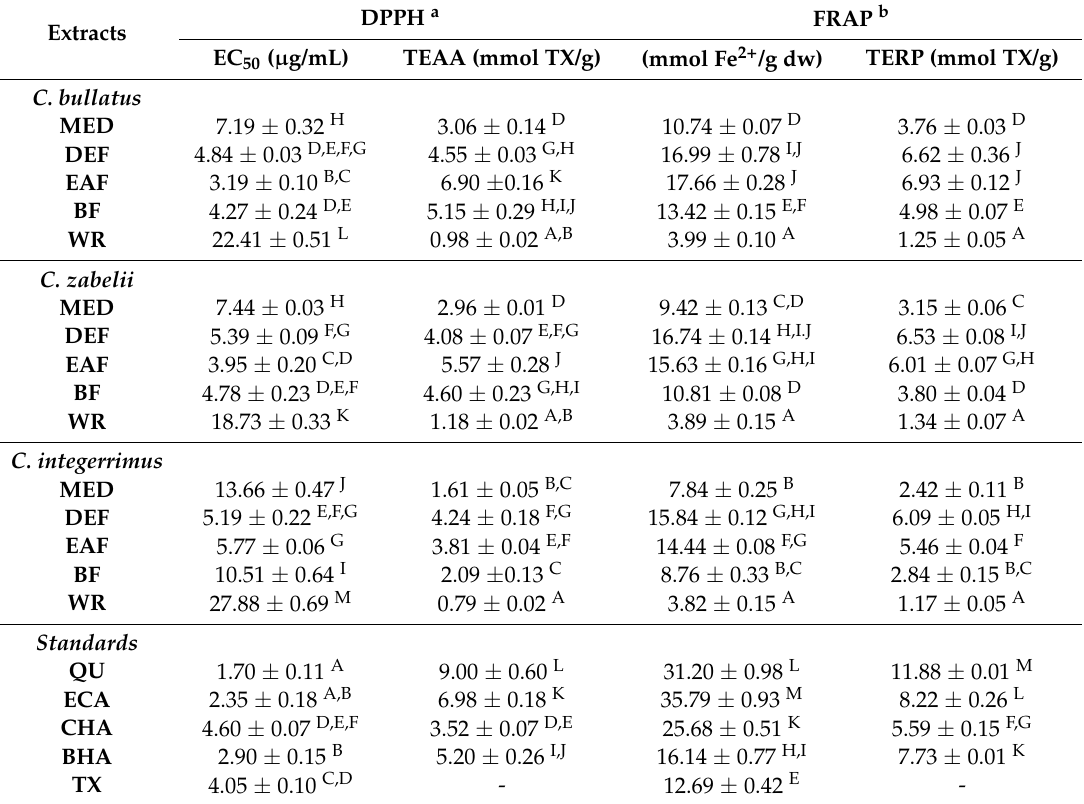
Table 2. Antioxidant capacities of Cotoneaster leaf dry extract and standard antioxidants in DPPH and FRAP